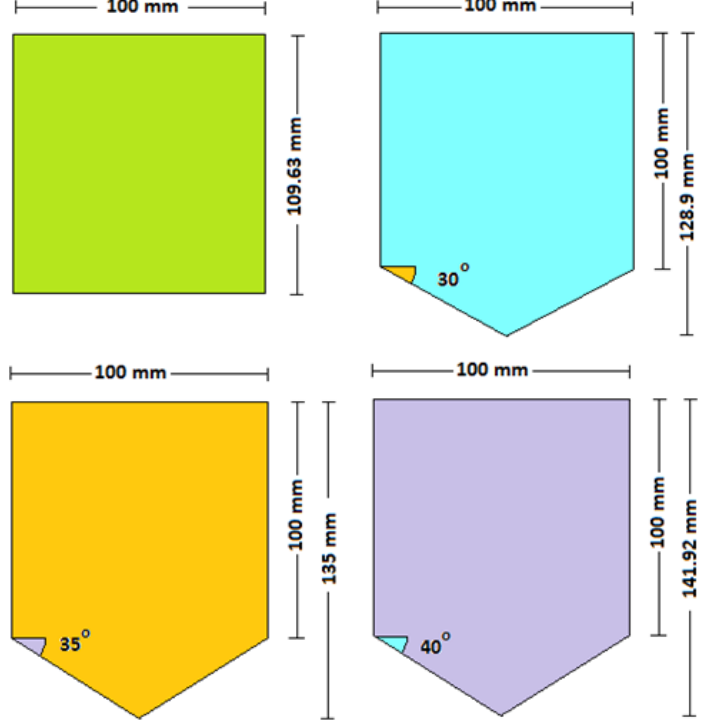
Fig. 2. Schematic shapes of tampers used by Arslan et al. (2007)